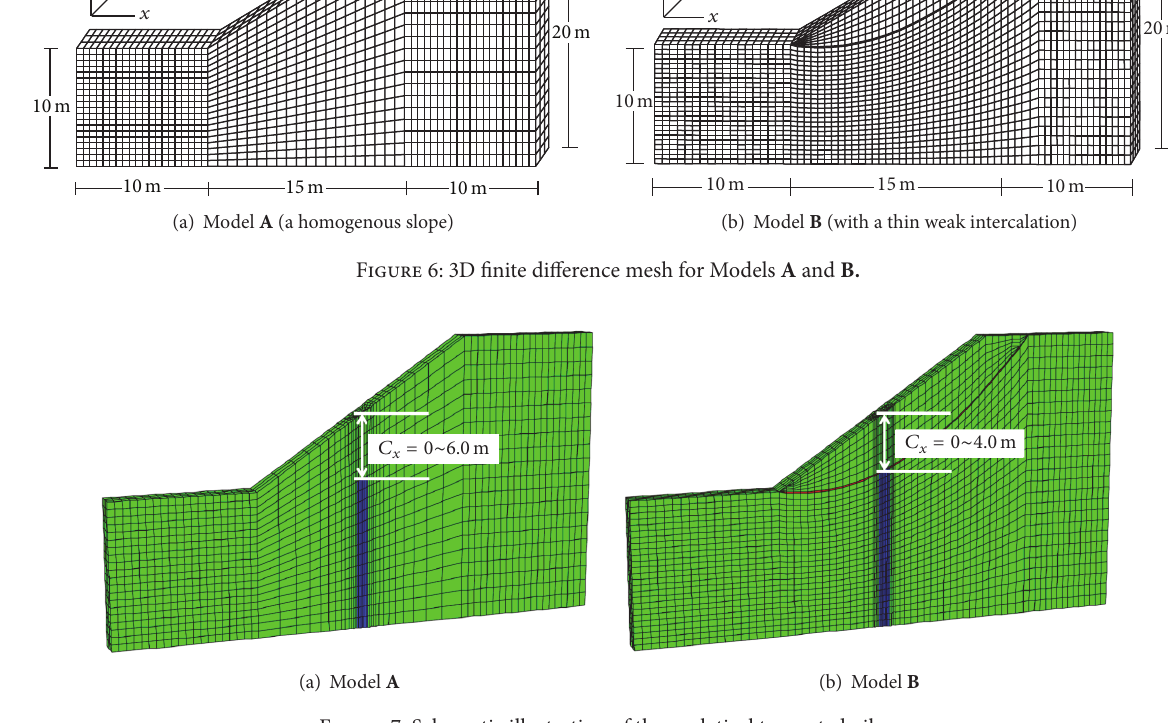
Figure 7: Schematic illustration of the analytical truncated piles.